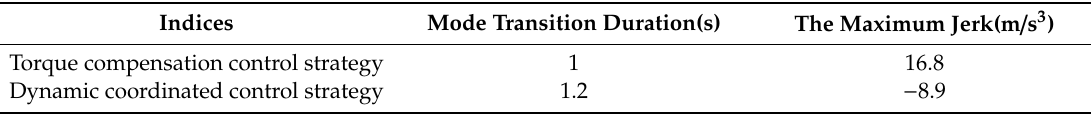
Table 4. Experiment results comparison.